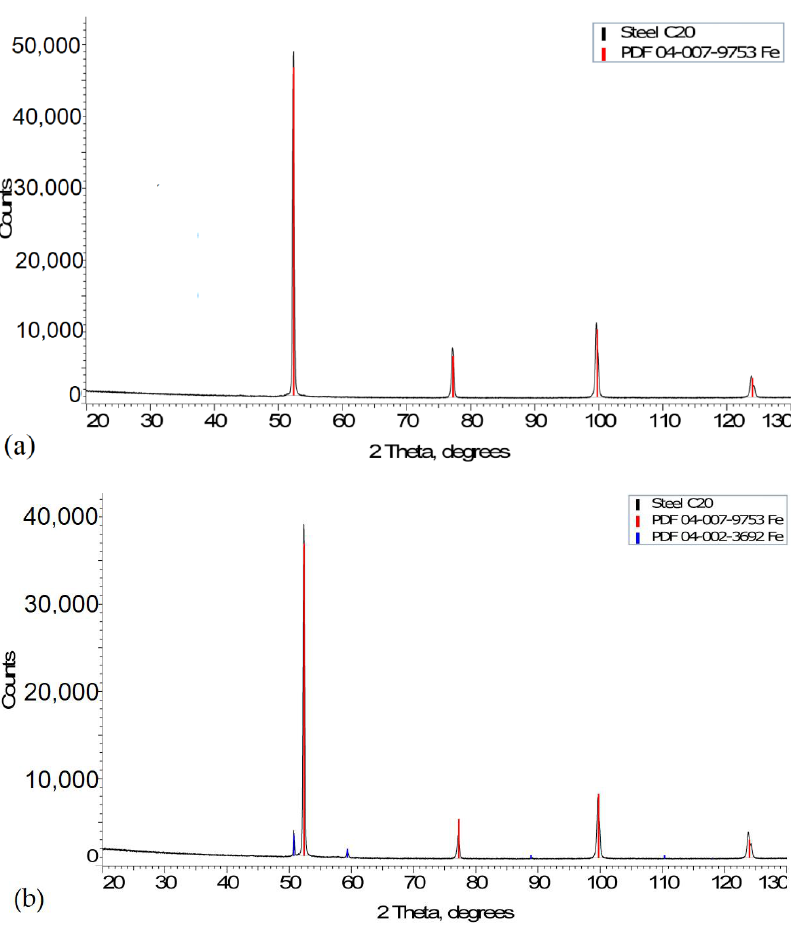
Figure 5. XRD patterns showing the phase composition: ( a ) base metal, ( b ) jet impact zone.